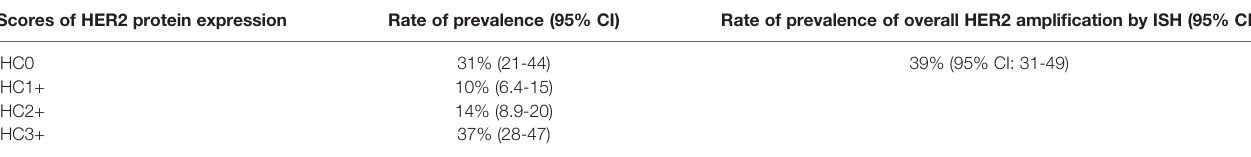
TABLE 3 | Summary of HER2 protein expression assessed by IHC and HER2 ampli fi cation assessed by ISH among SDC patients in the meta-analysis. Scores of HER2 protein